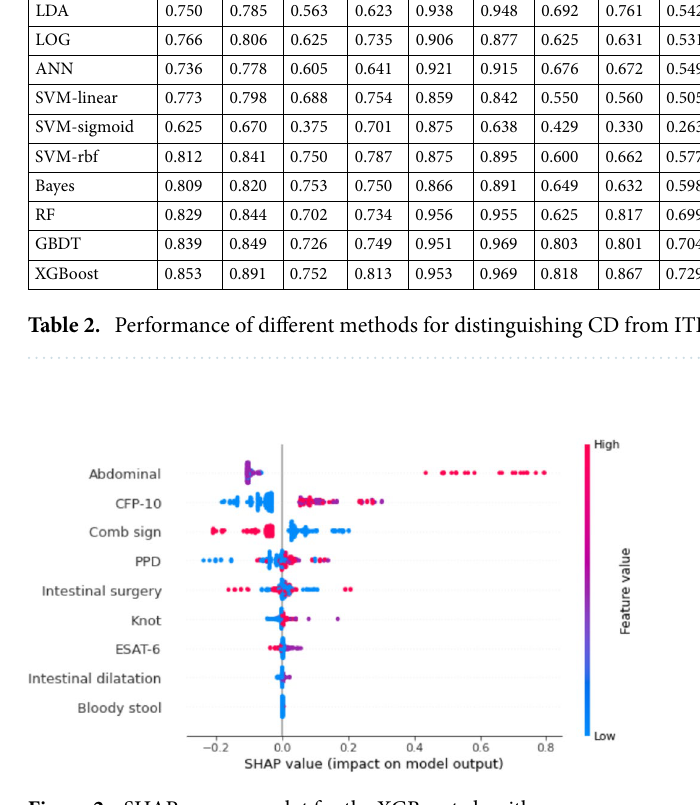
Figure 2. SHAP summary plot for the XGBoost